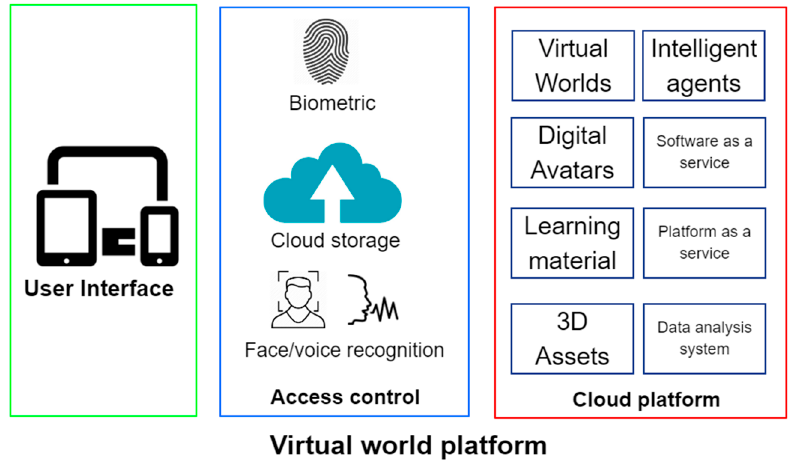
Figure 2. VoRtex high-level component-based architecture.